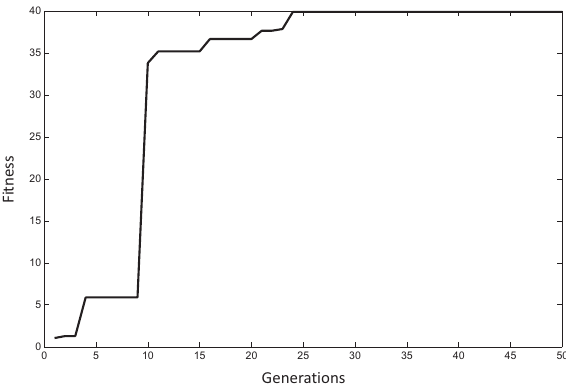
Figure 13. Best coral evolution in the CRO-5SL